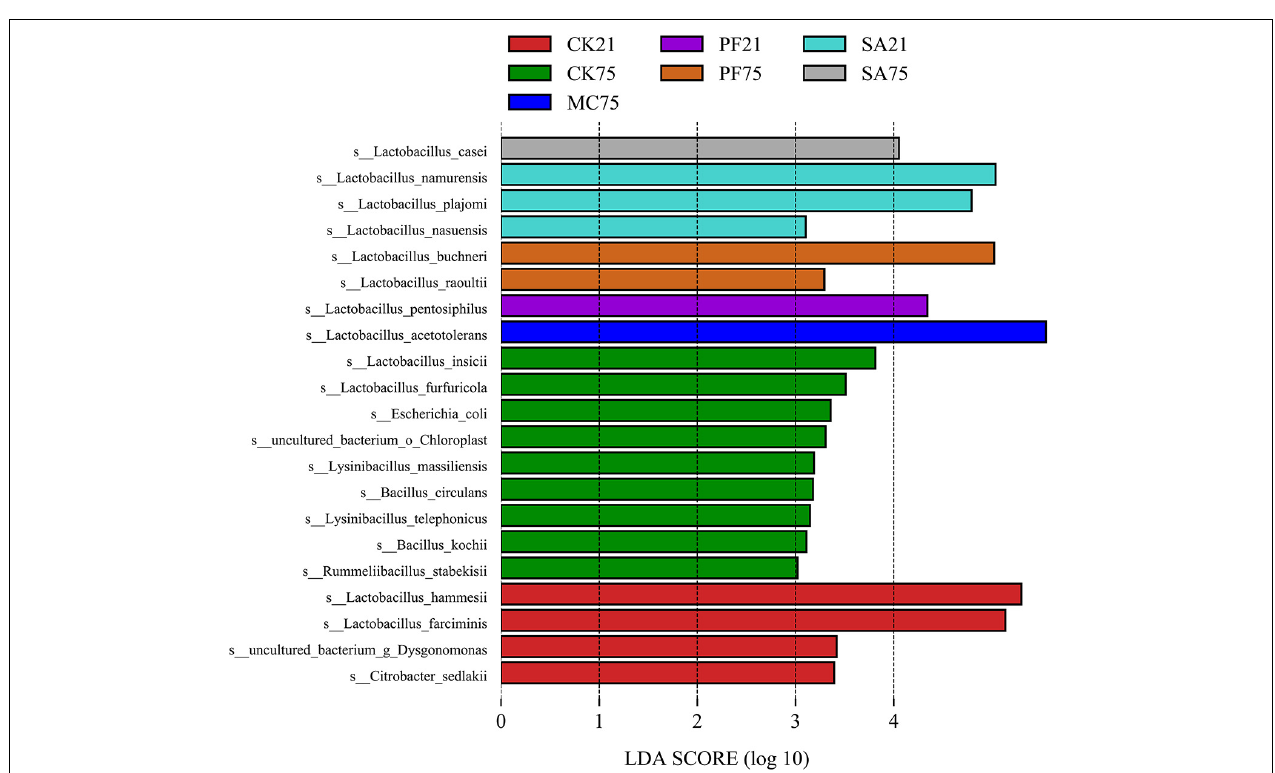
FIGURE 3 | Linear discriminant analysis effect size analysis of bacterial community (LDA score > 3.0) at species level in paper mulberry silages prepared by different herbal residues.